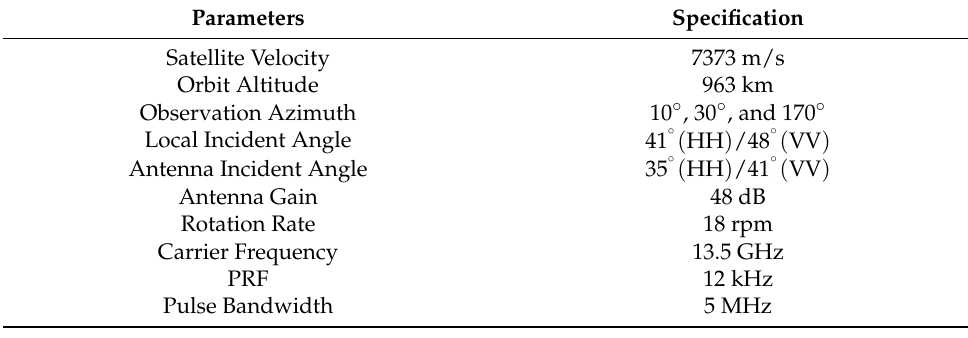
Table 2. Parameters of the Doppler scatterometer for data simulation.